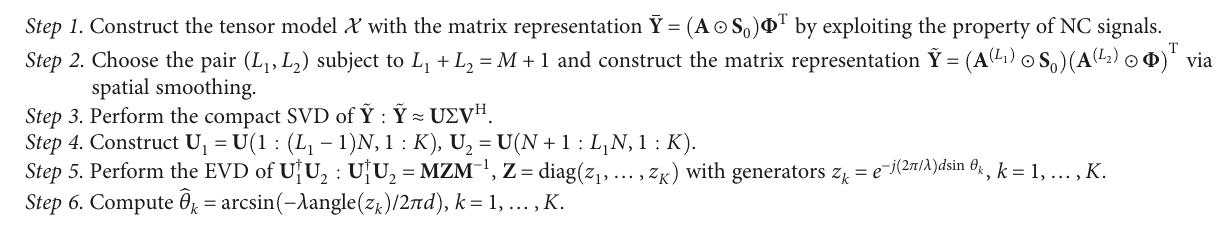
Algorithm 1: The Vandermonde constrained PARAFAC algorithm for NC signals DOA